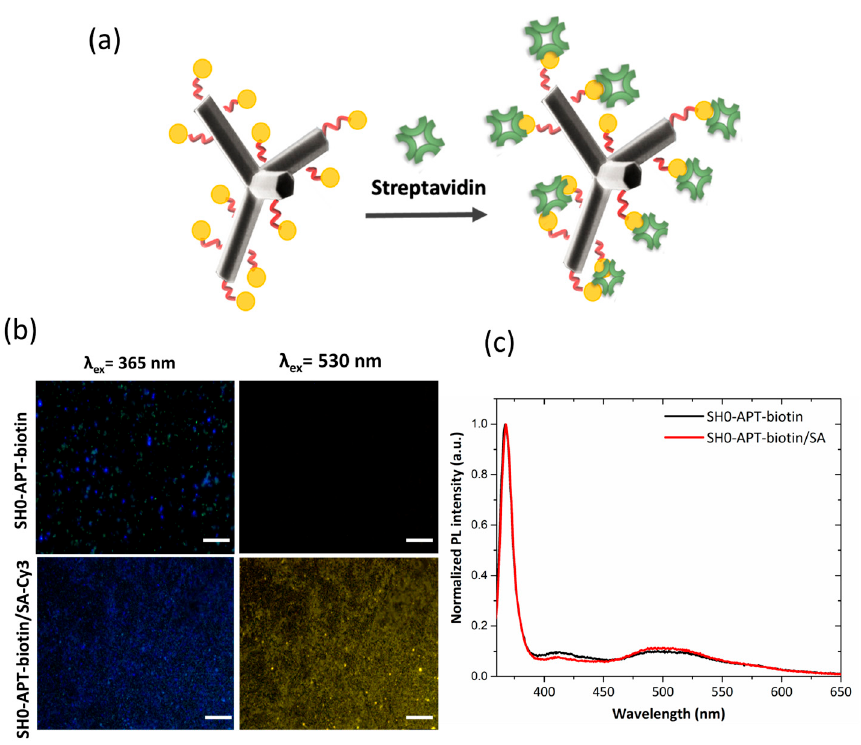
Figure 6. ( a ) Schematic representation of the streptavidin detection by biotinylated-ZnO-Ts. ( b ) Fluorescence microscope images of functionalized SH0 before and after the interaction with Cy3-labeled streptavidin. Scale bar 75 µm. ( c ) Normalized PL intensity spectra of functionalized ZnO-Ts before and after the exposure to label-free streptavidin at the excitation wavelength of 325 nm.